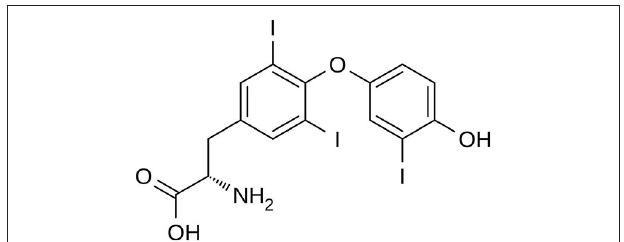
FIGURE 3 | Triiodothyronine